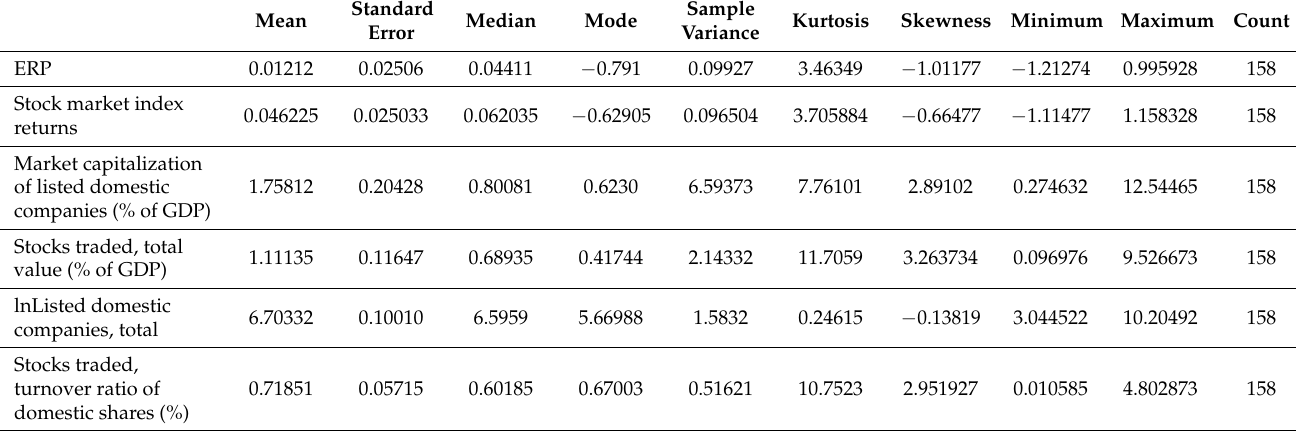
Table A4. Descriptive statistics for the high level of stock market